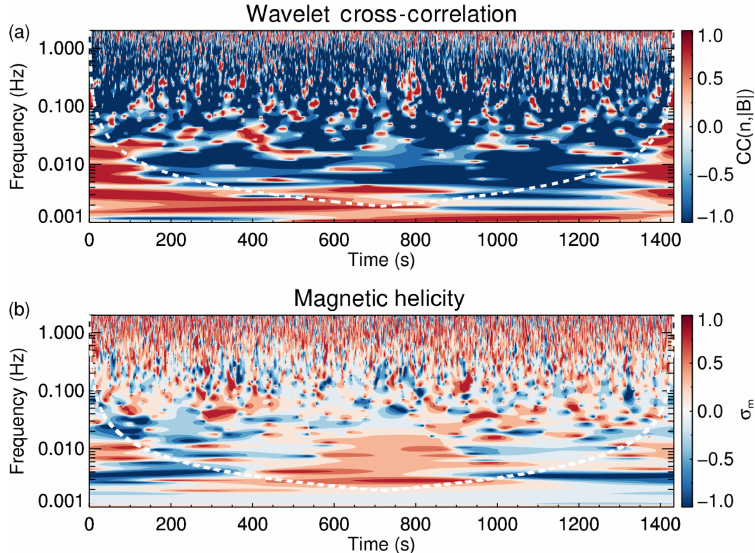
Figure 2. (a) Wavelet cross-correlation of the electron density and magnetic field strength. (b) Magnetic helicity. The white dashed line denotes the cone of influence region where the spectrum is unreliable due to edge effects.